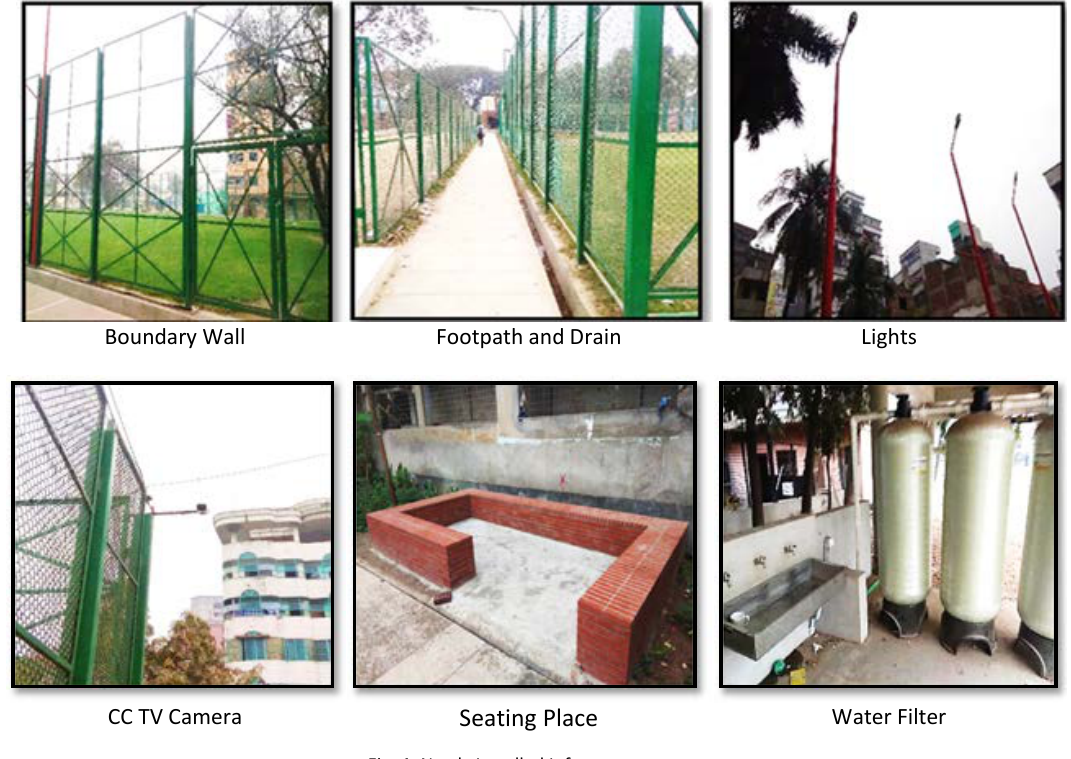
Fig. 4: Newly Installed Infrastructure